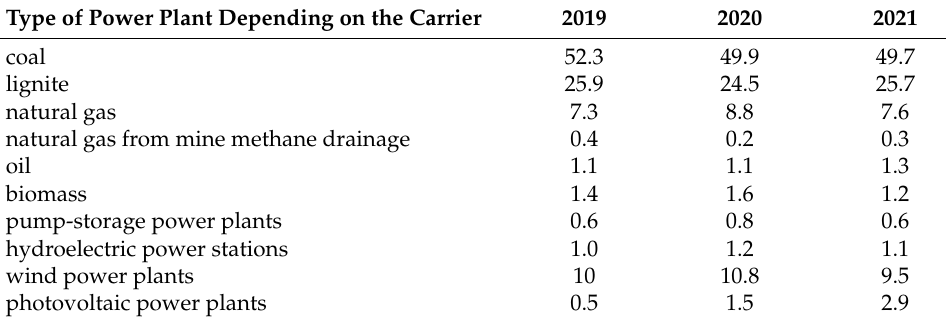
Table 5. Structure of electricity production in Poland